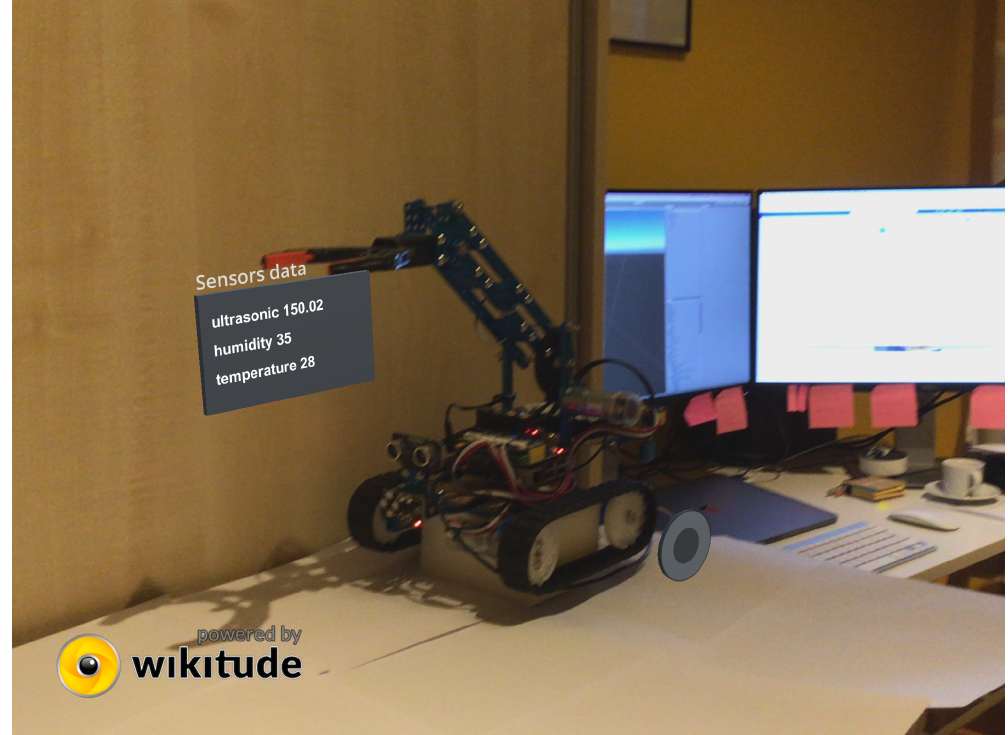
Figure 13. Recognized mechatronic device with dynamically generated GUI in augmented